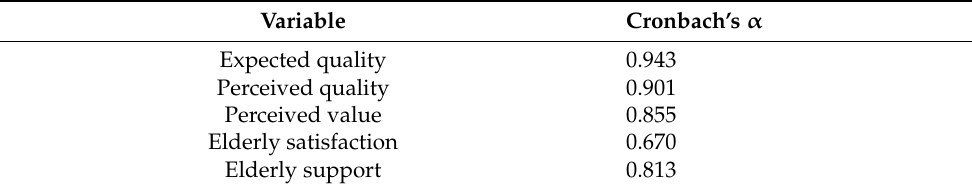
Table 5. Reliability